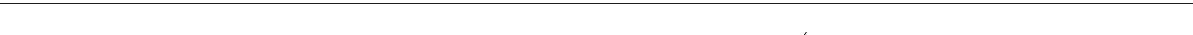
Fig. 2 MIF regulates NLRP3-dependent release of IL-1 family cytokines. a Primary murine WT or Mif − / − BMDMs were left untreated, primed with LPS alone (10 ng ml − 1 ), or primed with LPS before transfection of poly dA:dT (1 µ g ml − 1 ) for 5 h. WT BMDMs were left untreated, primed with LPS (10 ng ml − 1 ), or primed with LPS before the addition of COR123625 (50 µ M) for 2 h before transfection of b poly dA:dT (1 µ g ml − 1 ) or c fl agellin (250 ng ml − 1 ) for 5 h. Alternatively, following priming of WT BMDMs with LPS, cells were treated with d , g MSU (150 µ g ml − 1 ), e , h silica (150 µ g ml − 1 ), or ( f , i ) PBI-F2 peptide (100 µ g ml − 1 ) for 6 h. Levels of a – f IL-1 β and g – i IL-18 in cell culture supernatants were quanti fi ed by ELISA. j Primary WT or Mif − / − BMDMs were primed with LPS (10 ng ml − 1 ) in the presence or absence of recombinant murine MIF (rMIF, 10 ng ml − 1 ) before stimulation with nigericin (5 µ M) for 1 h. In addition, cells were treated with or without COR123625. Levels of IL-1 β in cell culture supernatants were assessed by ELISA. k Primary WT or Mif − / − BMDMs were primed with LPS (10 ng ml − 1 ) in the presence or absence of MIF-containing conditioned media from WT BMDM before stimulation with nigericin (5 µ M) for 1 h. Levels of IL-1 β in cell culture supernatants were assessed by ELISA. Data are expressed as means ± SEM, n = 3 mice. *P < 0.05, ** P < 0.01, *** P < 0.005, **** P < 0.001, one-way ANOVA with a correction provided by the Tukey's multiple comparisons test